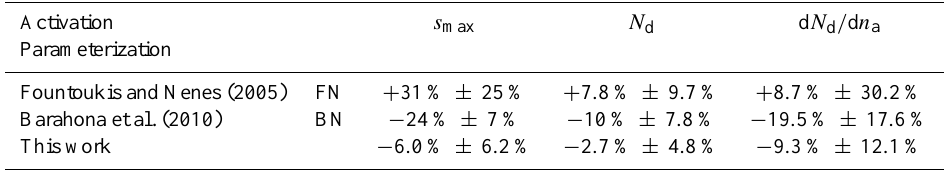
Table 2. Summary of comparisons against parcel-model simulations expressed as (cid:15) ± σ (cid:15) . Activation s max d N d / d n a